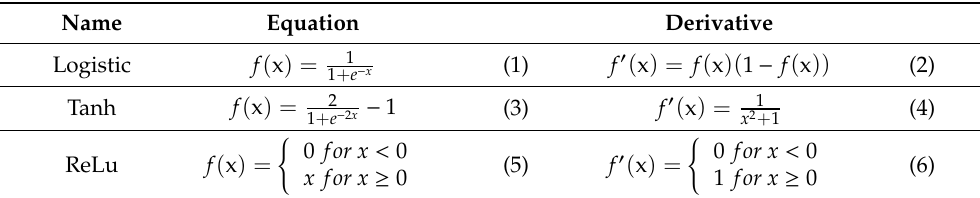
Table 2. Types of functions used in neural network hidden nodes.